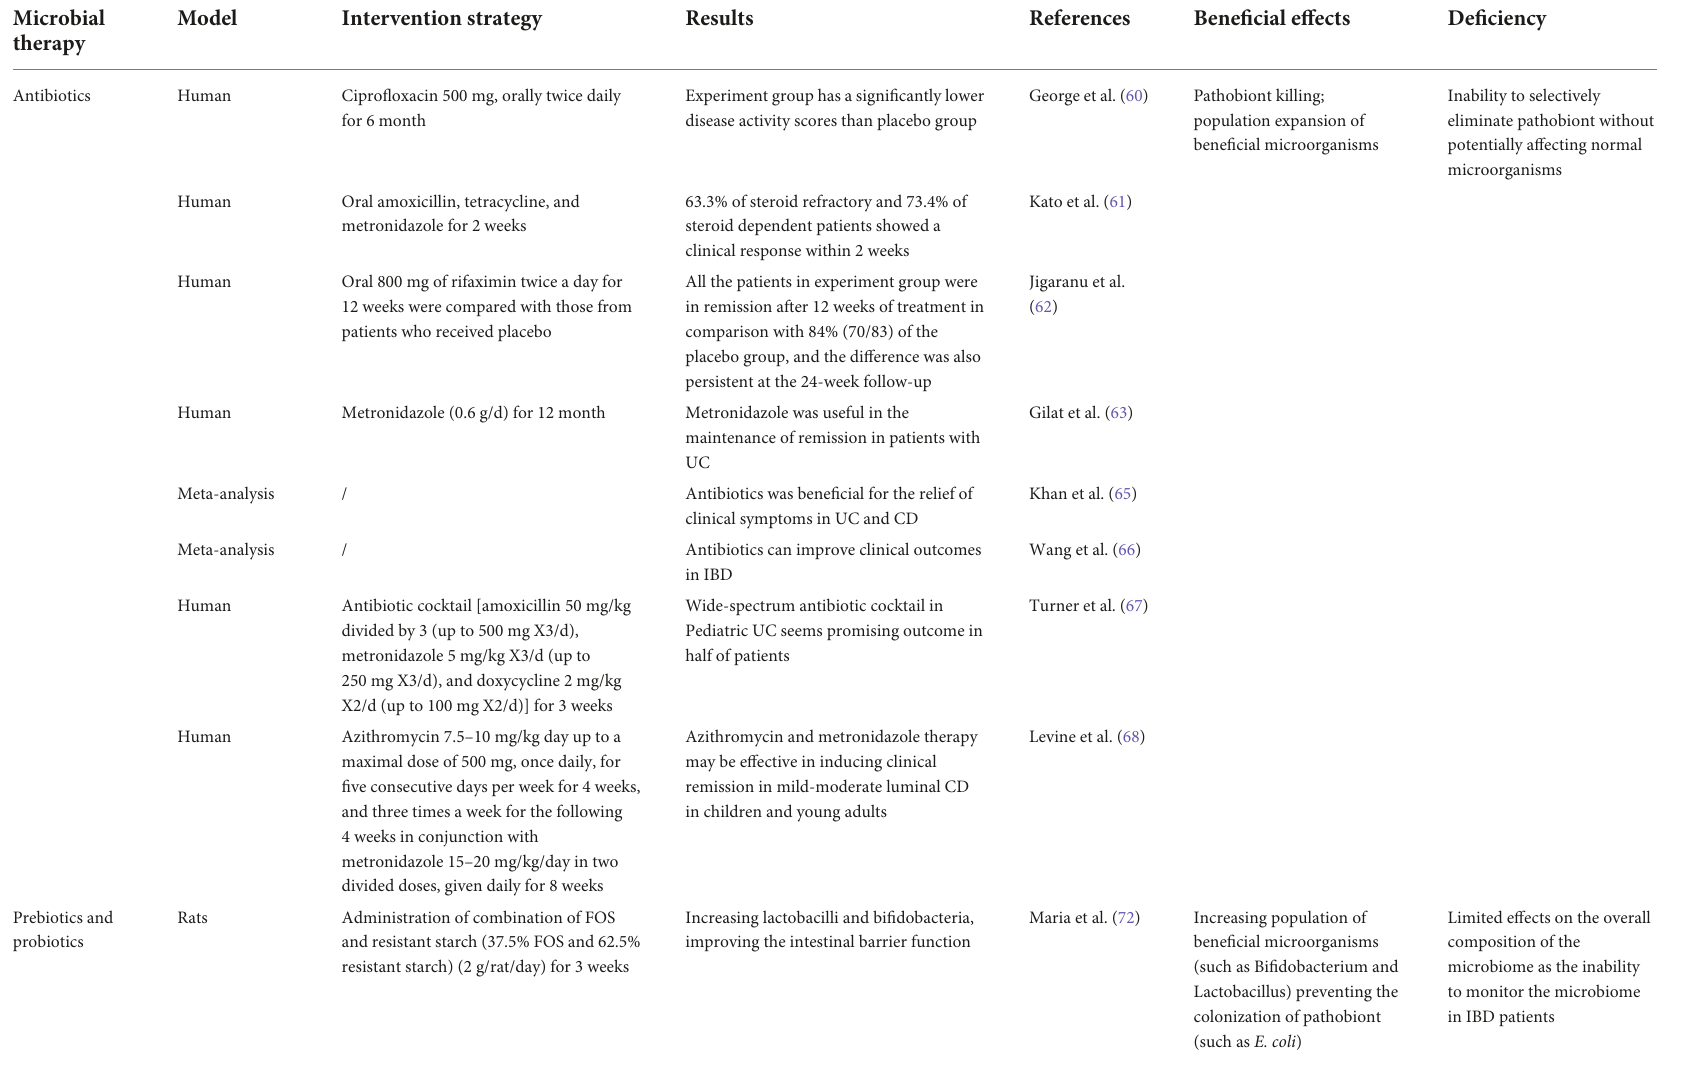
TABLE 1 The relationship between different aspects of microbial